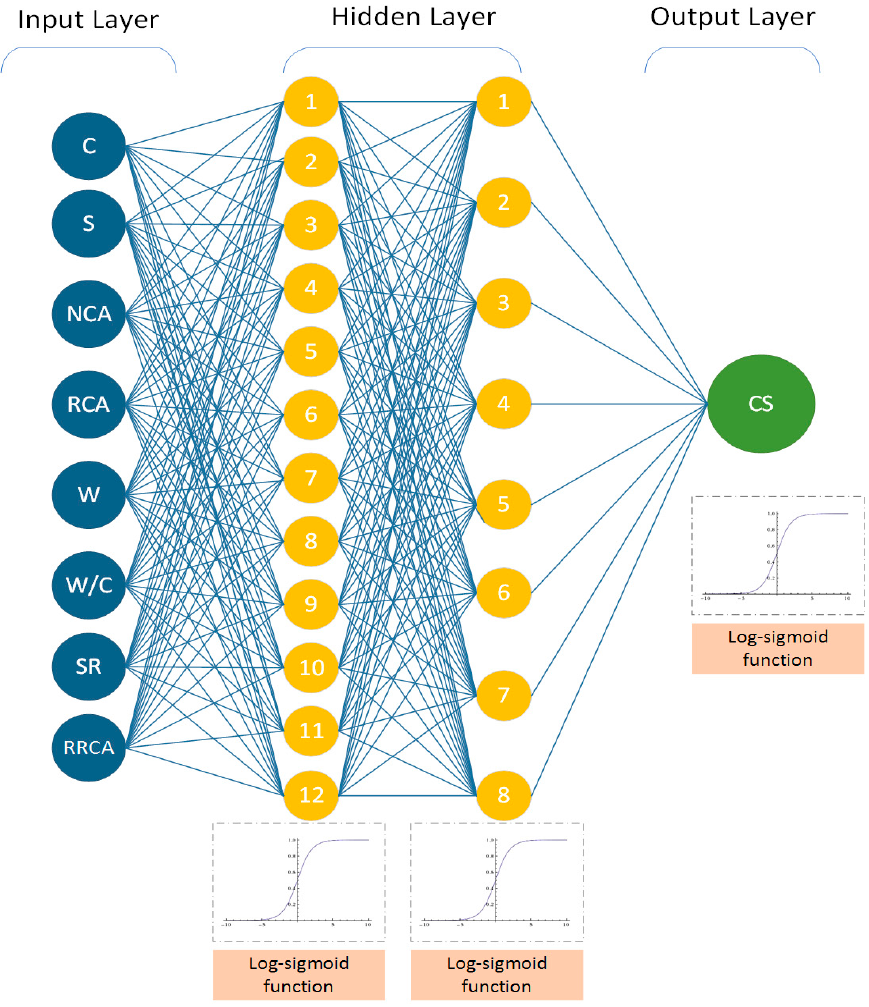
Figure 24. Optimal BPNN structure.